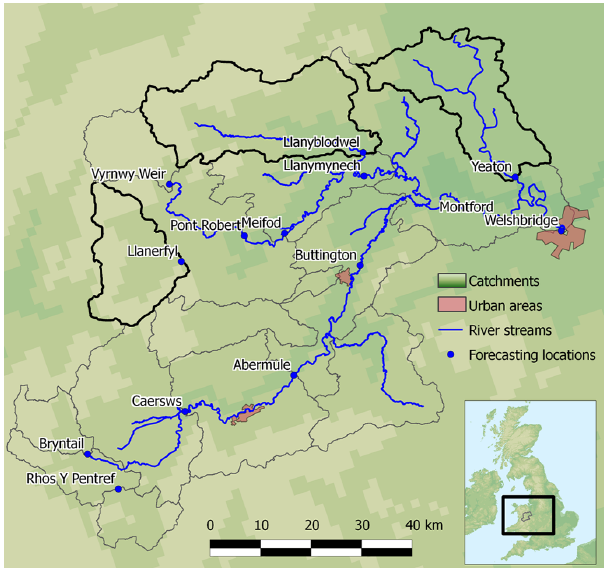
Figure 4. The Upper Severn catchments: Yeaton, Llanyblodwel and